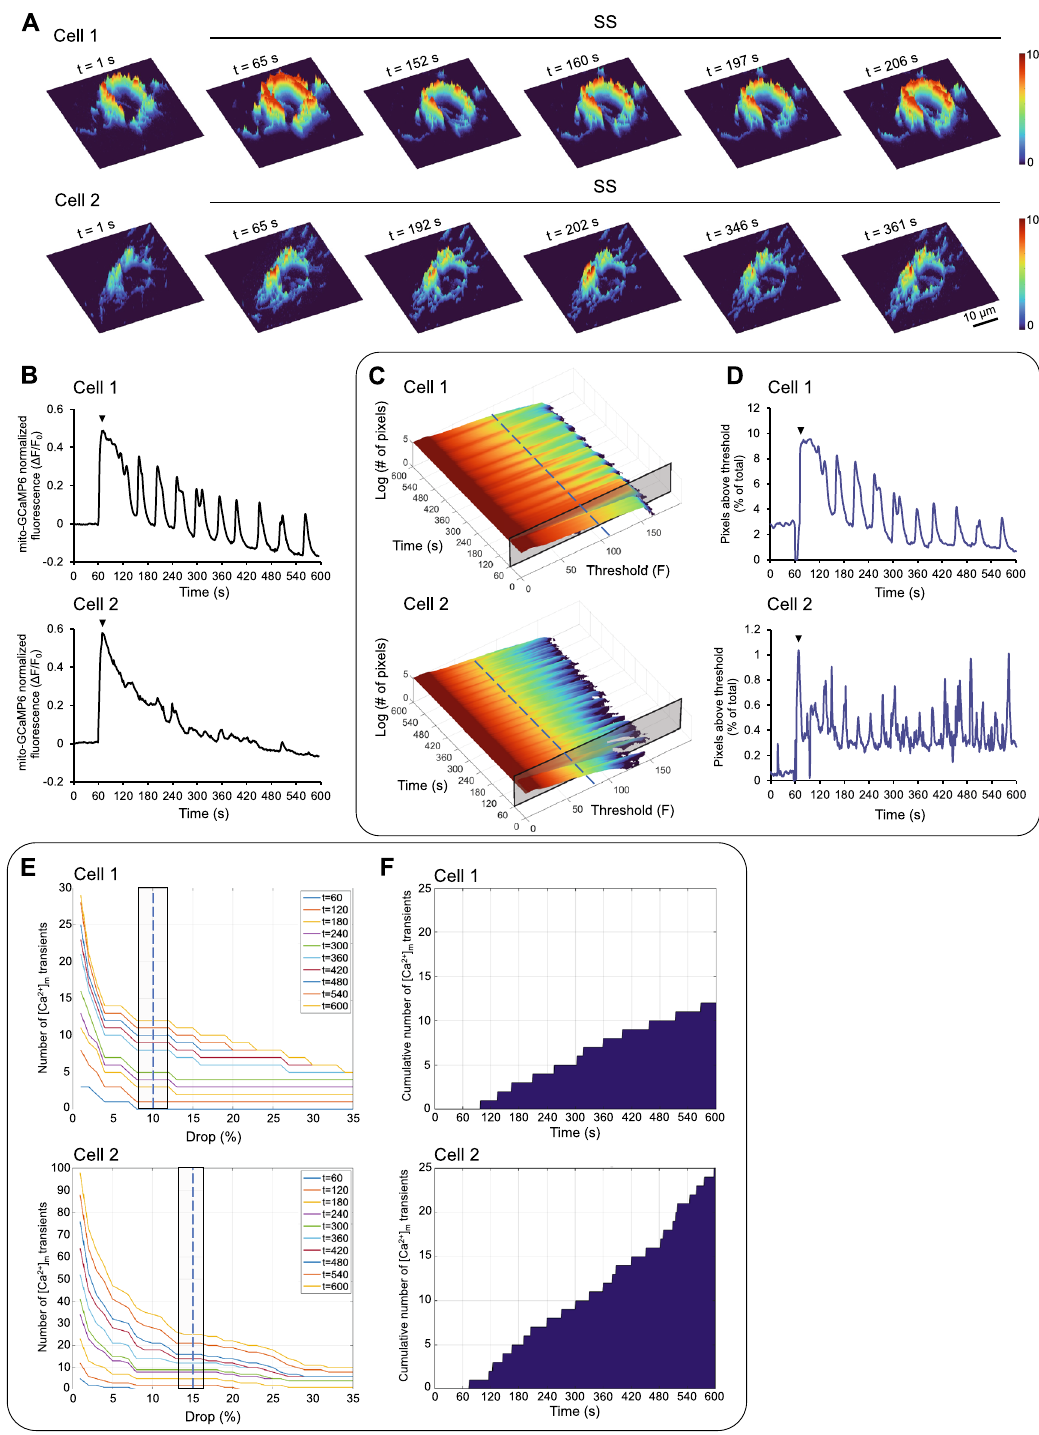
Figure 2. Mathematical analysis to identify [Ca 2+ ] m transients. ( A ) Pseudo-3D fluorescent images of two extreme cases: Cell 1 exhibited [Ca 2+ ] m transients in ~ 10% of its area, whereas cell 2 in ~ 1% of its area. ( B ) The ΔF/F 0 temporal profile for cell 1 identified the transients; it did not identify them in the case of cell 2. ( C ) 3D topography surfaces of log 10 (number of pixels) vs. threshold intensity vs. time were constructed using MATLAB to assist in selecting the best threshold value for each cell. ( D ) Using the chosen threshold value, the number of pixels above the threshold intensity (as a percentage of total cell area) was plotted vs. time for each cell. ( E ) The numbers of [Ca 2+ ] m transients were plotted as a function of different drop percentage values and times for each cell, and the drop value that yielded the most persistent transients was chosen. ( F ) Using the chosen threshold and drop values, the cumulative number of transients was plotted vs. time (1 min static followed by 9 min SS) for each